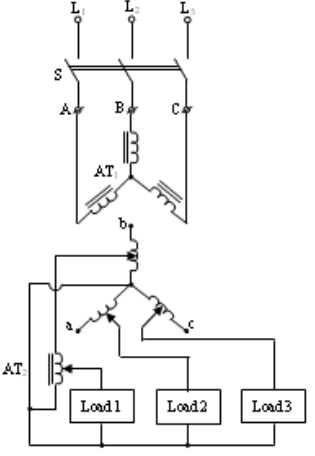
Figure 1. Laboratory experimental setup.